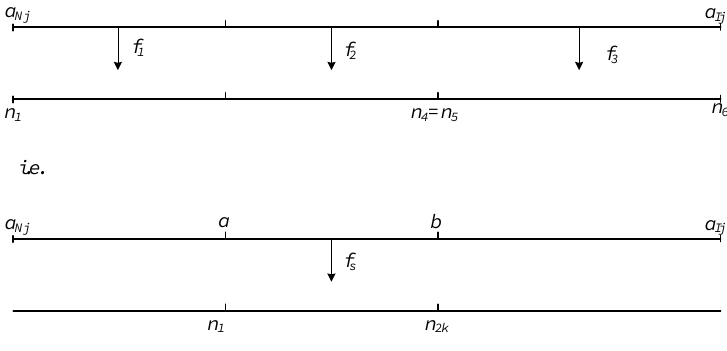
Figure 1. Mapping of sub-intervals into the criteria interval.